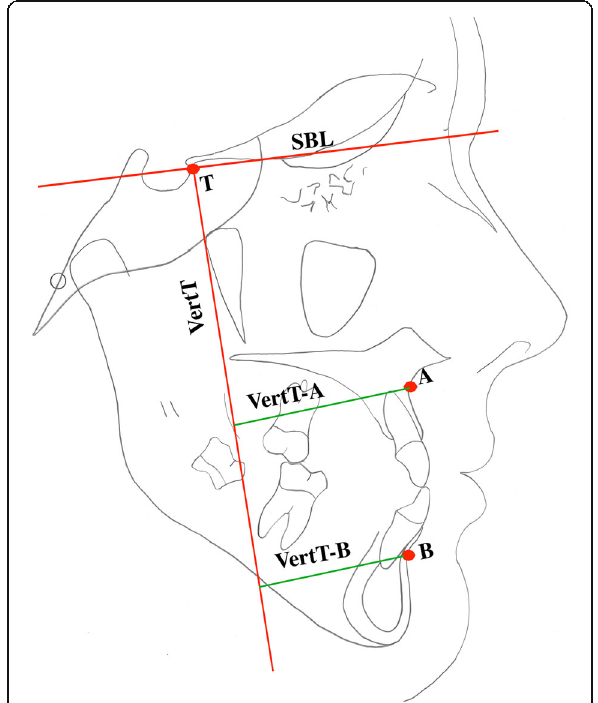
Fig. 3 Horizontal skeletal measurements. Point T: The most superior point of the anterior wall of the sella turcica at the junction with tuberculum sellae, Vert T: Line perpendicular to SBL and passing through point T, Vert T-A: Horizontal distance traced from the perpendicular line from Vert T to point A, and Vert-B: Horizontal distance traced from the perpendicular line from Vert T to point